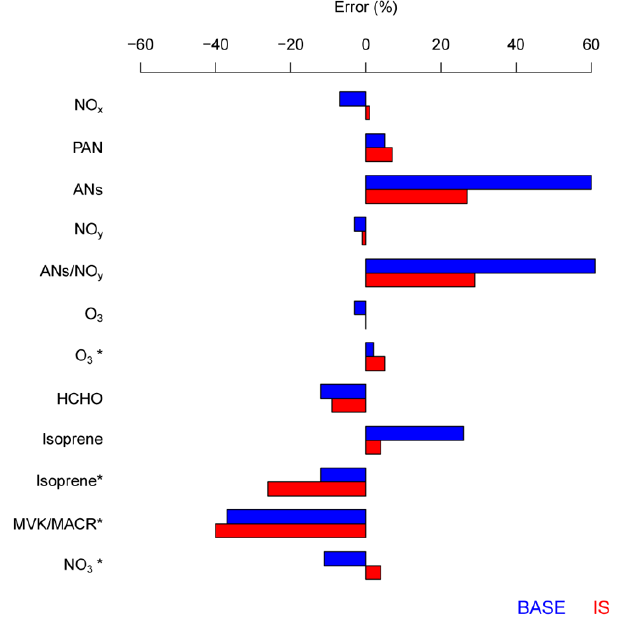
Fig. 2. Evaluation of CMAQ using observations between the sur- face and 2km (10–18LST, except NO 3 is 21–04LST). ∗ indicates data from WP-3D. HCHO is based on the average of the University of Rhode Island and NCAR measurements due to the systematic difference ( ∼ 35%) between the two datasets. The CMAQ model results are sampled at the GPS location of the 1min measurements. Error is reported the median of the quantity CMAQ minus observa- tions, divided by the median of the observations.